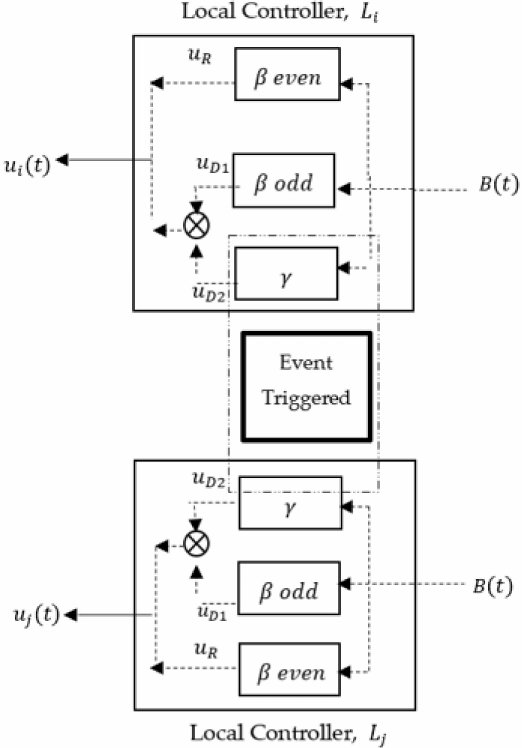
Figure 4. Agent local controller with event-triggered system between agent i and neighbor j